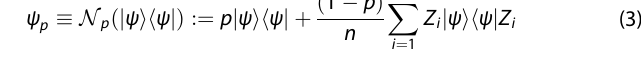
; π ; π ; π ; π . The data displayed 16 8 6 5 4 7 þ cos ð 4 ϑ Þð Þ . Additionally, a 2